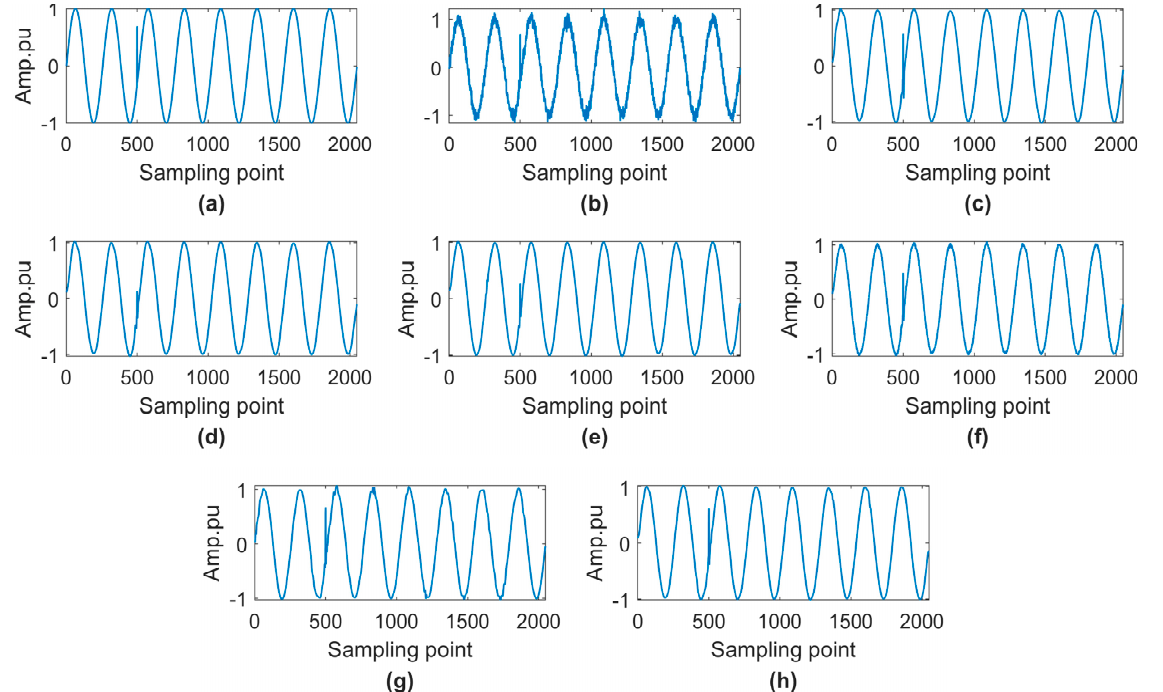
Figure 5. ( a ) Noiseless impulsive transient; ( b ) impulsive transient with a SNR of 20 dB; ( c ) hard thresholding denoising; ( d ) soft thresholding denoising; ( e ) denoising following the method described in Ref. [1]; ( f ) denoising following the method described in Ref. [2]; ( g ) denoising following the method described in Ref. [27]; ( h ) denoising following the proposed method